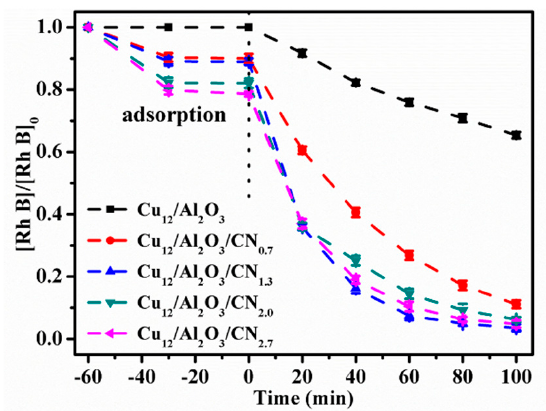
Figure 7. [Rh B] / [Rh B] 0 as a function of time in the presence of 1 g / L Cu 12 / Al 2 O 3 / CN y composite (y = 0, Figure 7. [Rh B]/[Rh B] 0 as a function of time in the presence of 1 g/L Cu 12 /Al 2 O 3 /CN y composite (y = 0.7, 1.3, 2.0, and 2.7 wt %). Reaction conditions: [Rh B] 0 = 20 mg / L, [H 2 O 2 ] 0 = 10 mM, V = 100 mL, 0, 0.7, 1.3, 2.0, and 2.7 wt %). Reaction conditions: [Rh B] 0 = 20 mg/L, [H 2 O 2 ] 0 = 10 mM, V = 100 mL, T = T = 25 ◦ C, pH 4.9 (unadjusted). 25 °C, pH 4.9 (unadjusted).